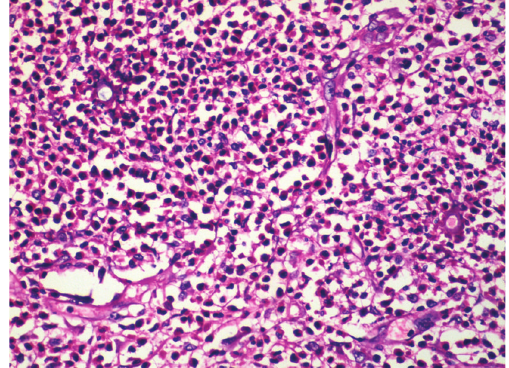
Figure 4: Photomicrograph showing Splendore-Hoeppli bodies on Gomori silver methenamine silver (GMS) stain. GMS delineates aseptate hyphal filaments (GMS,